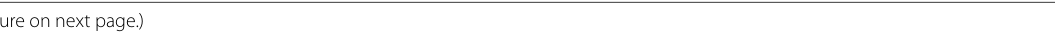
Fig. 1b. k Spatial visualization of the resistivity structure beneath the active